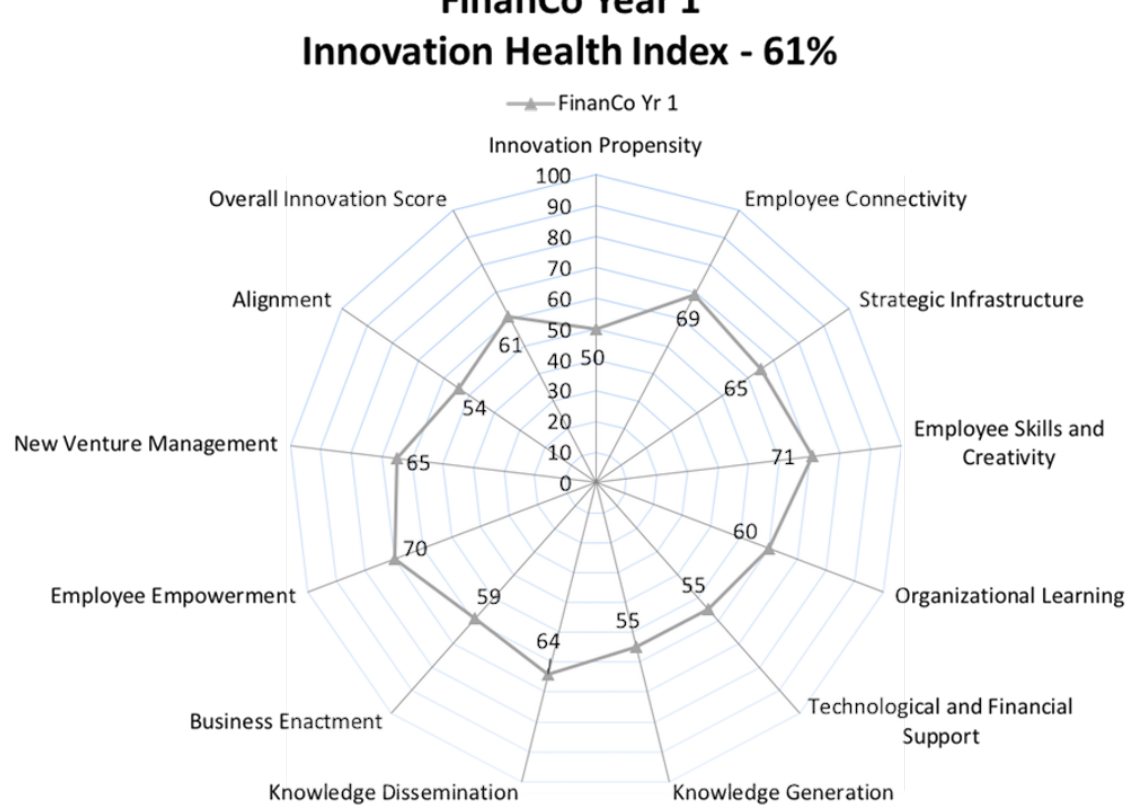
Fig. 4. FinanCo’s Initial Innovation Benchmark